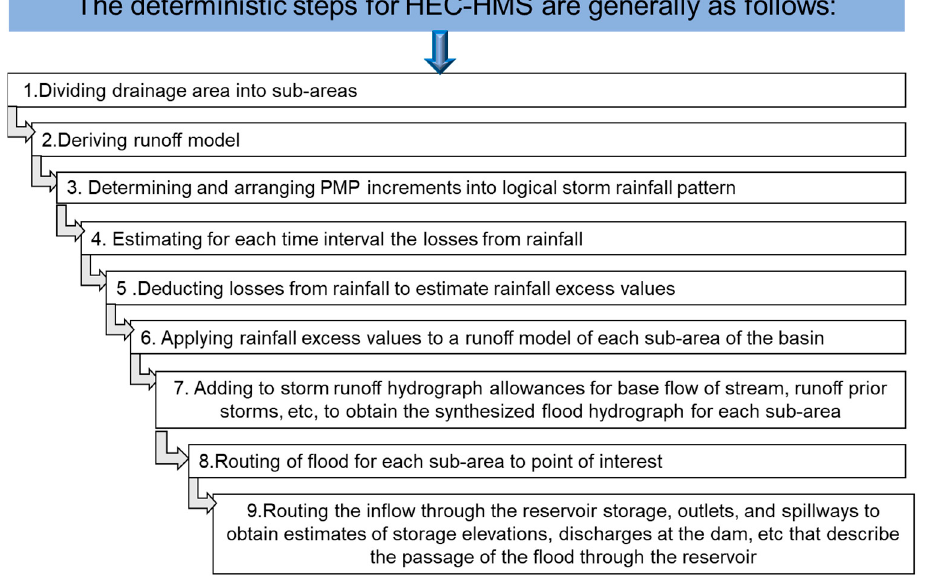
Figure 5. Steps for HEC-HMS simulation.